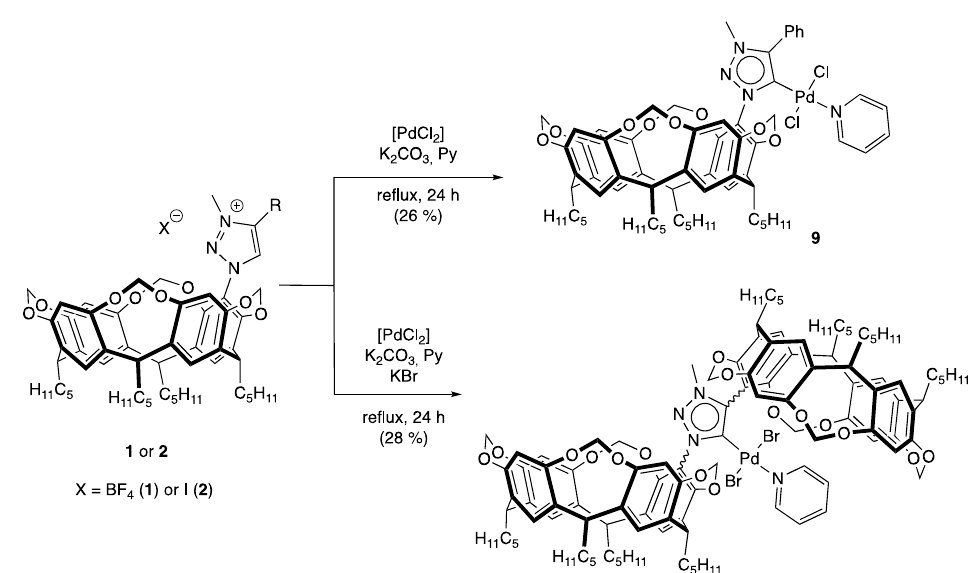
Scheme 2. Synthesis of the PEPPSI-type palladium complexes 9 and 10 .